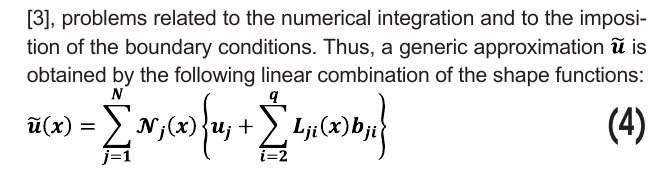
(Barros et al. [3]) j